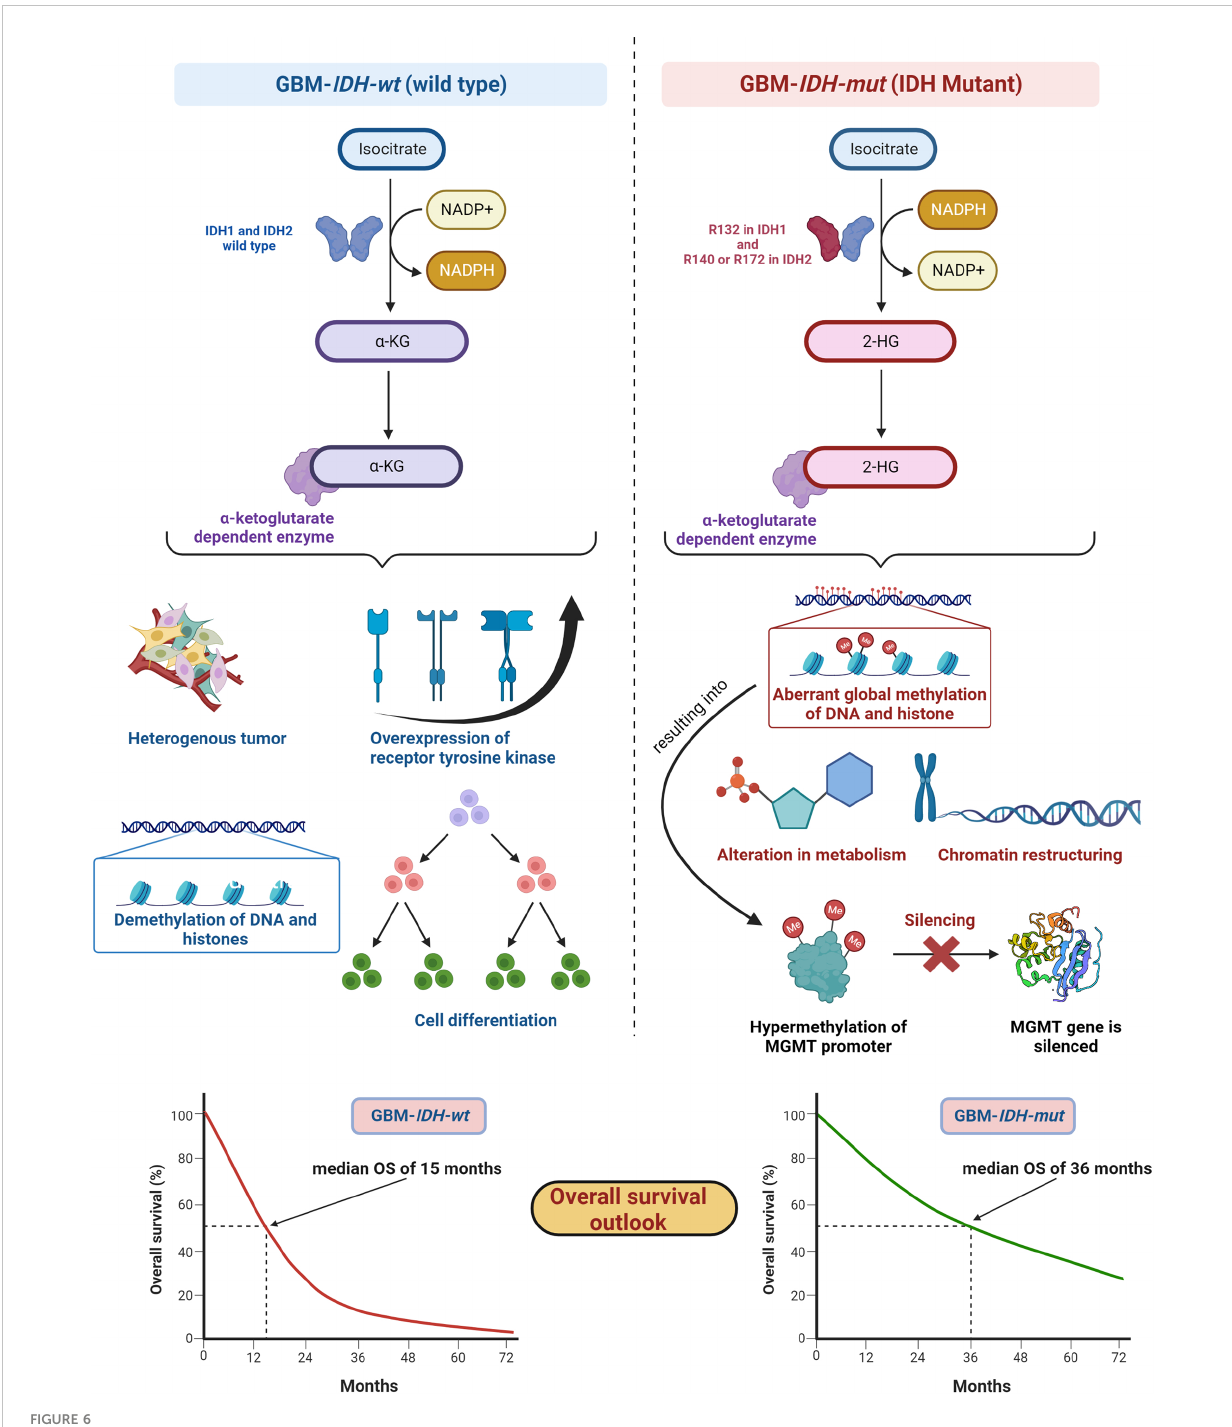
FIGURE 6 IDH status in GBM (1) GBM-IDH-wt and (2) GBM-IDH-mut: IDH-1 is localized in cytoplasm whereas IDH-2 is mitochondrial. In normal conditions, IDH1 and IDH2 catalyze substrate isocitrate to a -KG. Mutation on arginine on 132 to histidine (R132H) is most frequent mutation of IDH-1 in GBM; however, R140 or R172 is a common mutation in IDH-2 (106). IDH-mutation generates 2-HG as an oncometabolite. 2-HG create intense effect on cellular system via alteration in metabolism, chromatin restructuring, and aberrant global methylation of DNA and histone, which further hypermethylates MGMT promoter and consequently silences MGMT gene resulting into extended OS compared with IDH wt-type. IDH-wt results into heterogeneous tumor formation, alteration in receptor tyrosine kinases (EGFR and PDGFRA), demethylation of DNA and histones, and cell differentiation (107). Median OS for IDH-GBM-mut is 36 months however it is only 15 months in case of